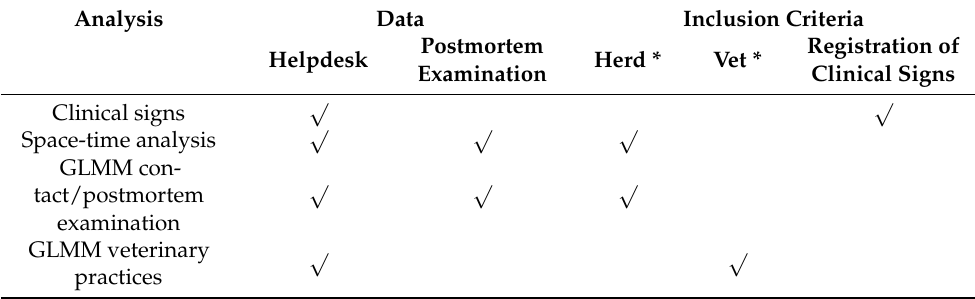
Table 1. Overview of inclusion criteria and used dataset per analysis of this study.